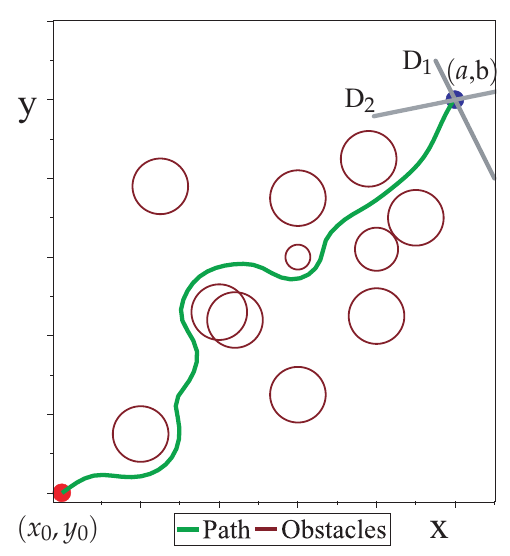
Figure 2. Path obtained with the EHPPM for a mobile